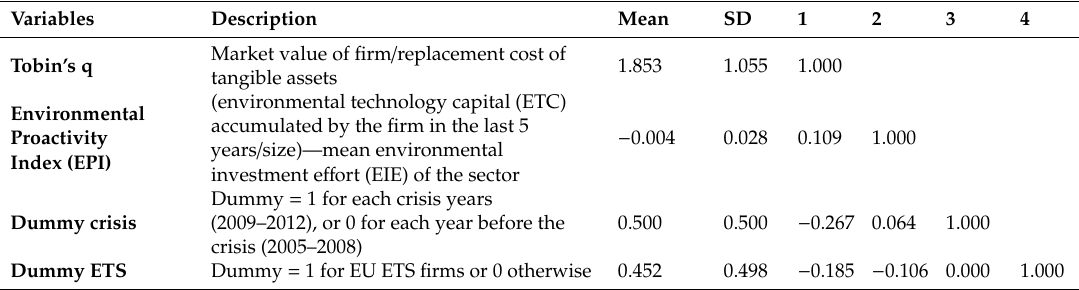
Table 2. SDs and correlations for quantitative